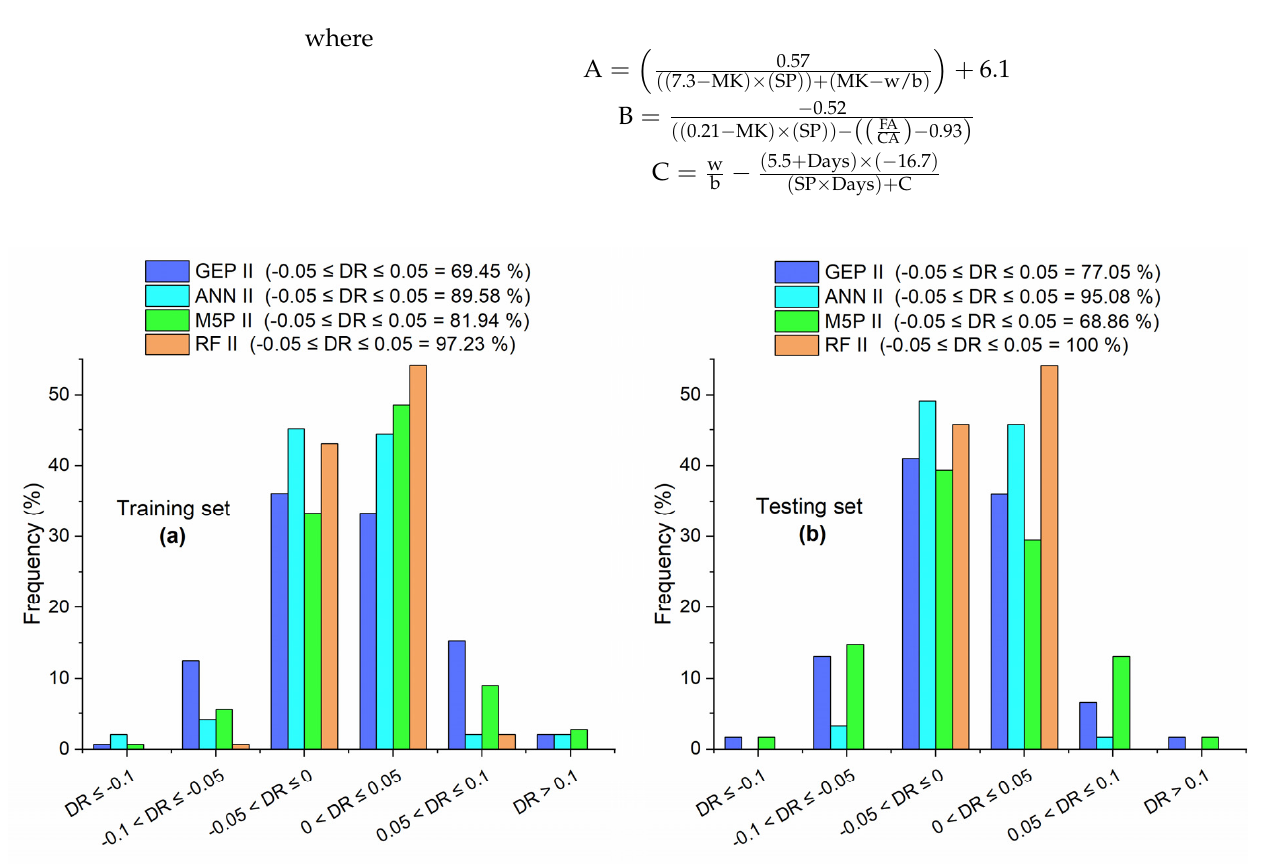
Figure 17. DR values of GEP II, ANN II, M5P II, and RF II for ( a ) training set and ( b ) testing set. Table 6. Statistical evaluation of GEP II, ANN II, M5P II, and RF II.